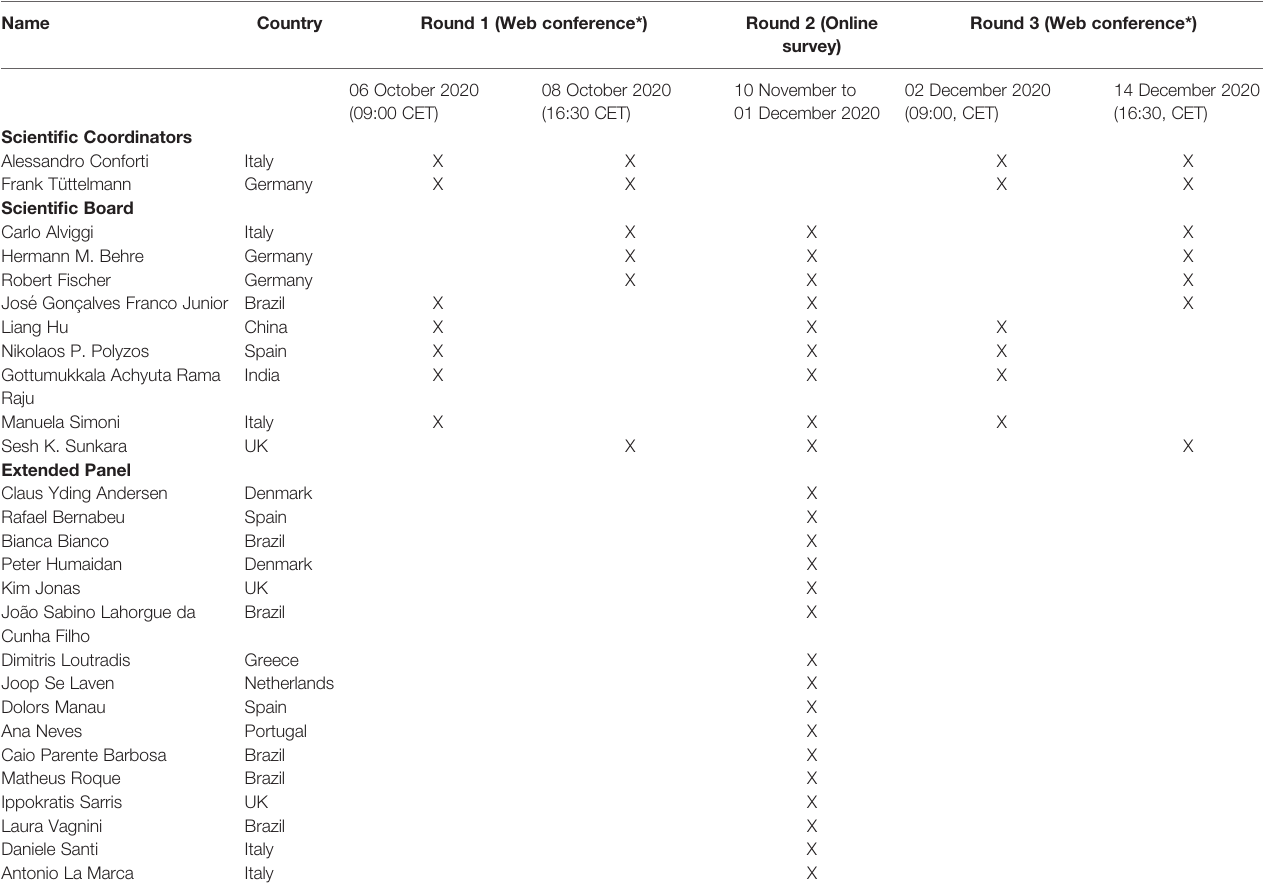
TABLE 2 | Participants involved in rounds 1 – 3 of the